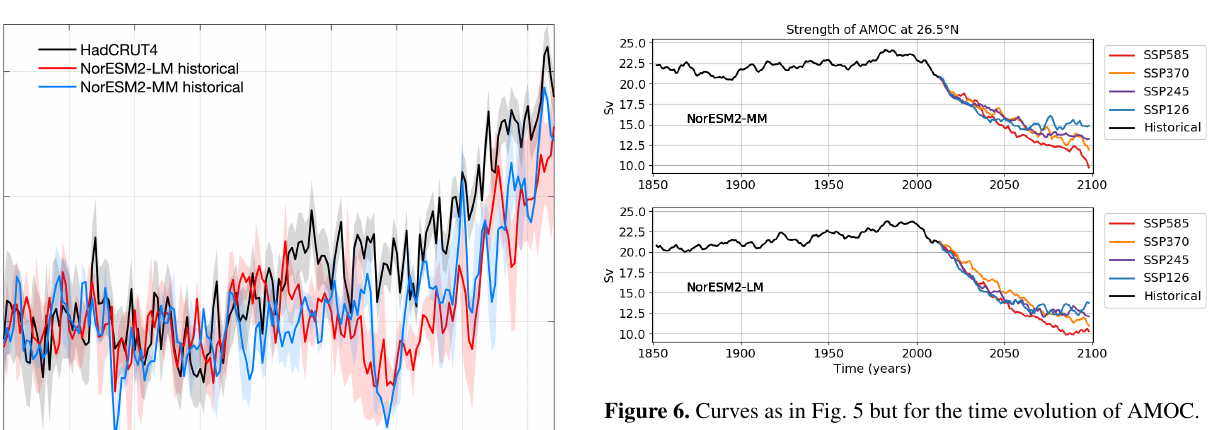
Figure 6. Curves as in Fig. 5 but for the time evolution of